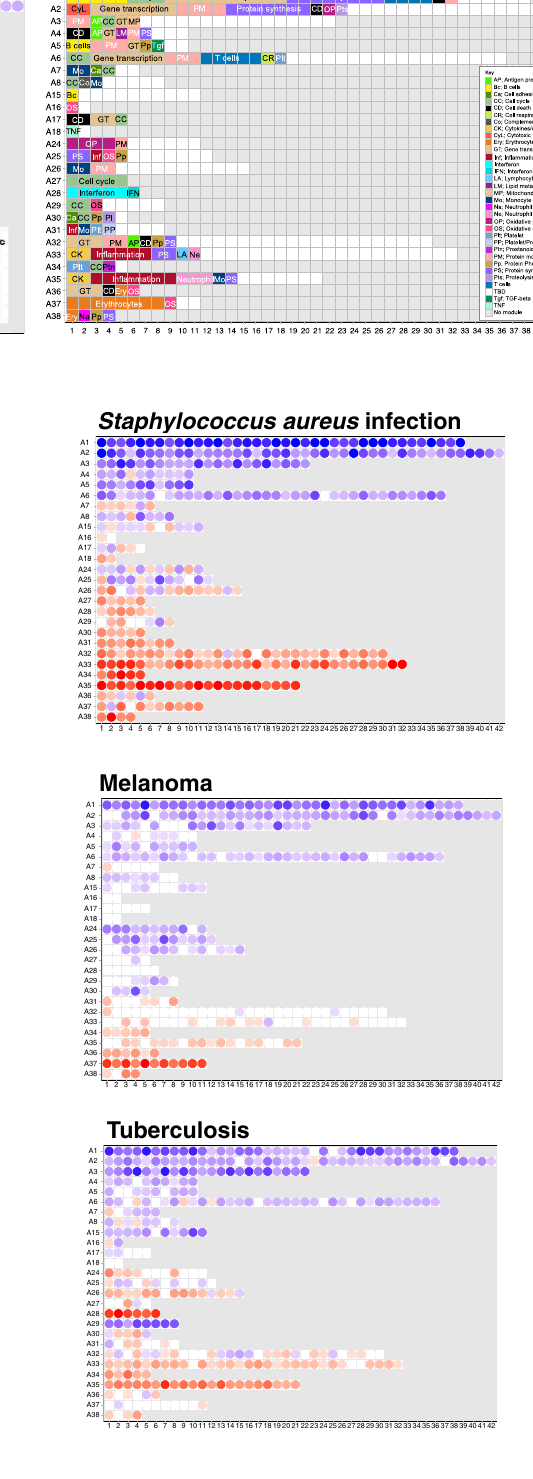
interactive circle packing plots. These interactive plots make it possible to zoom in and out, determine spatial relationships and interactively browse the very large compendium of analysis reports and heatmaps generated as part of our annotation efforts. (Fig. 4; links are listed in Supplementary Table 2 and are also accessible via the BloodGen3 web application: https://drinchai. shinyapps.io/BloodGen3Module/, and a demonstration video